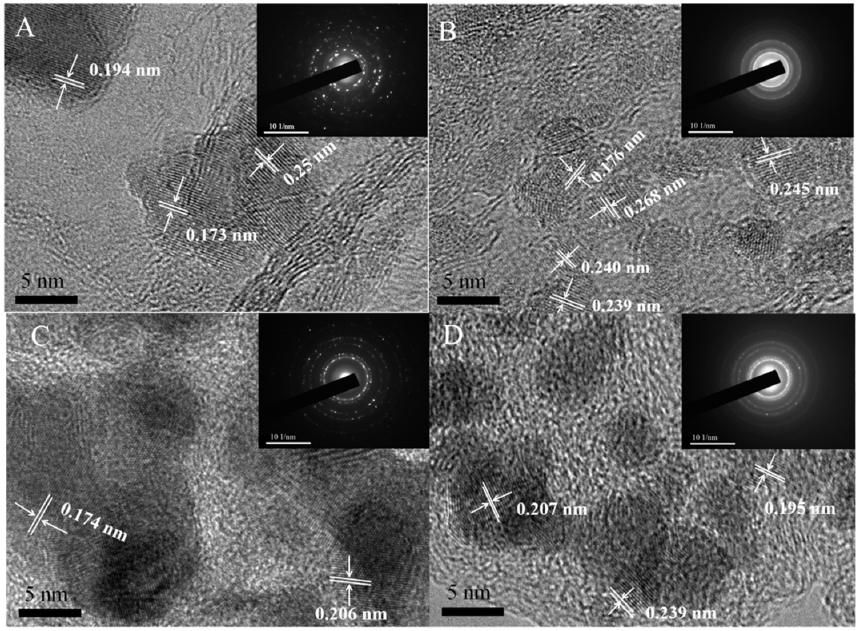
Figure 3. HRTEM tests of Cu-NC ( A ), Fe-NC ( B ), Ni-NC ( C ), Pd-NC ( D ). The inset is the corresponding selected area electron diffraction patterns.